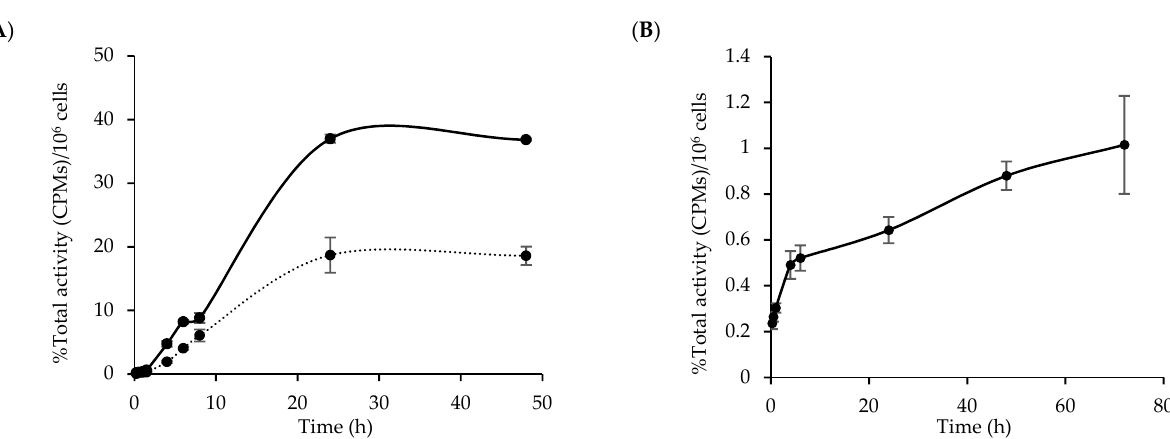
Figure 4. Percentage of ( A ) cell-associated (solid line) and internalized (dotted line) measured at 37 °C, and ( B ) passive accumulation of [ 64 Cu]Cu-NOTA C3-TP in HCT116 cells performed at 4 °C as function of time. Data are presented as the percentage of total activity (%)/10 6 cells.